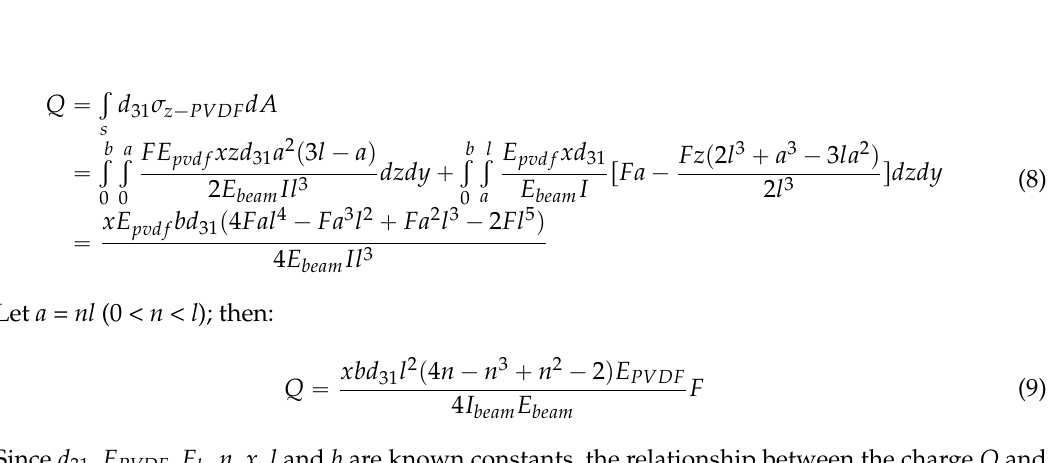
Figure 5. Beam stretching.